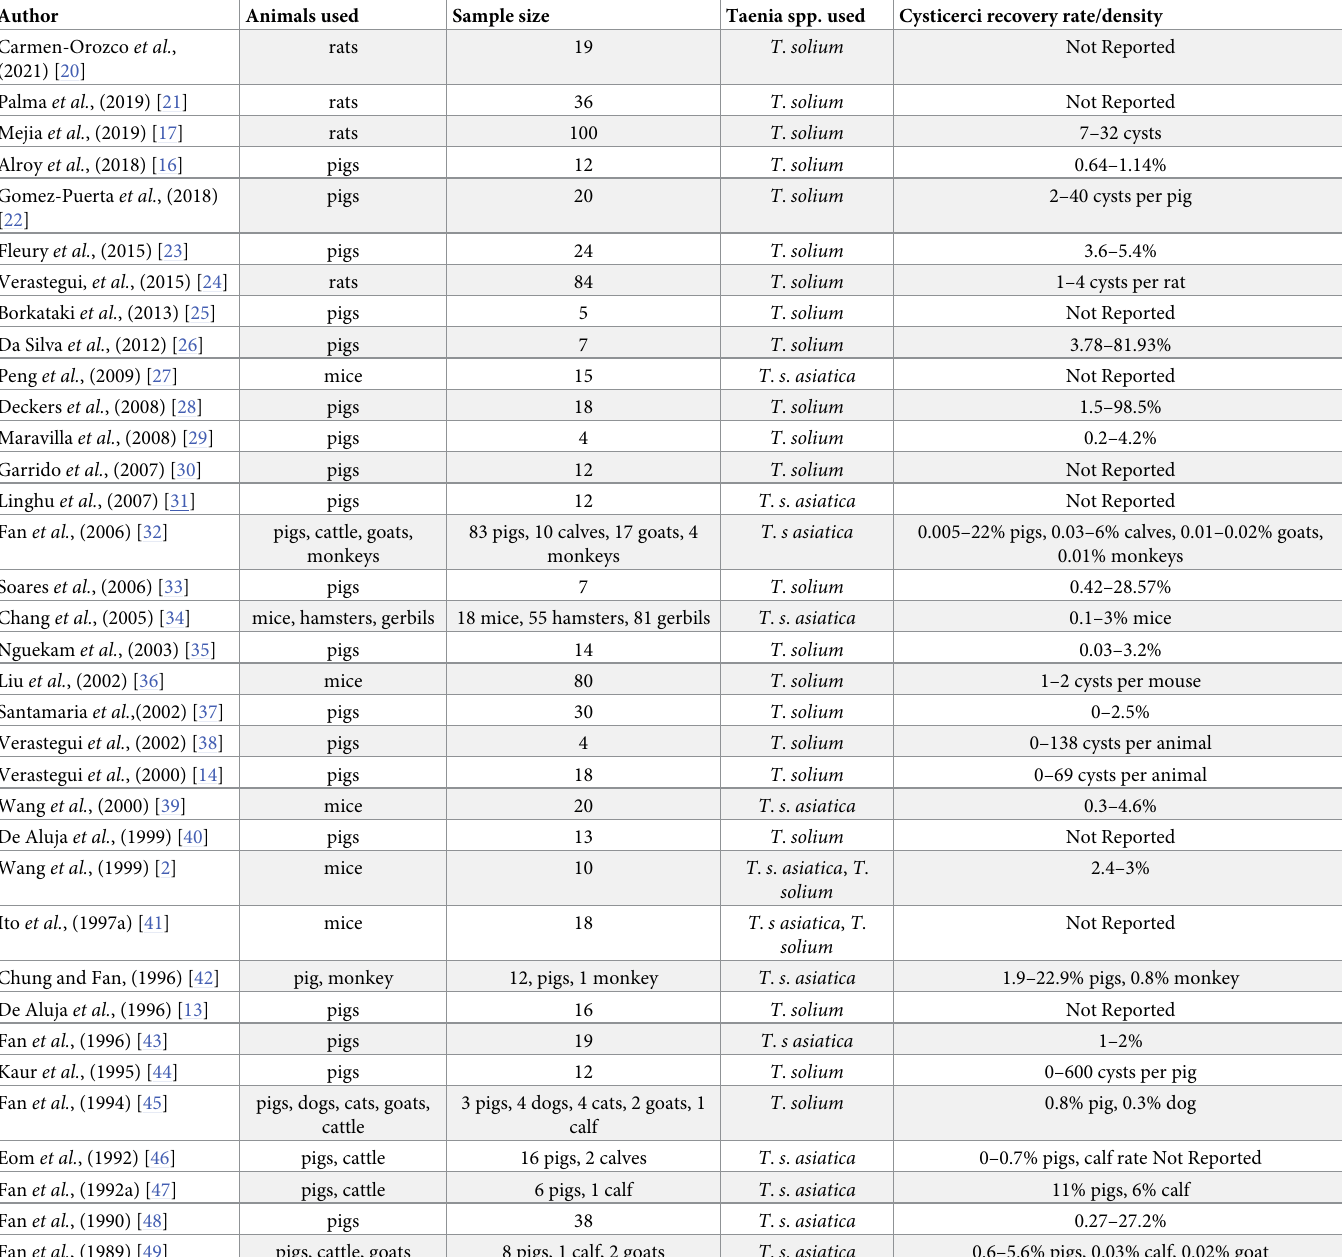
Table 1. Description of the animal models used in the included studies for T . solium and T . s . asiatica